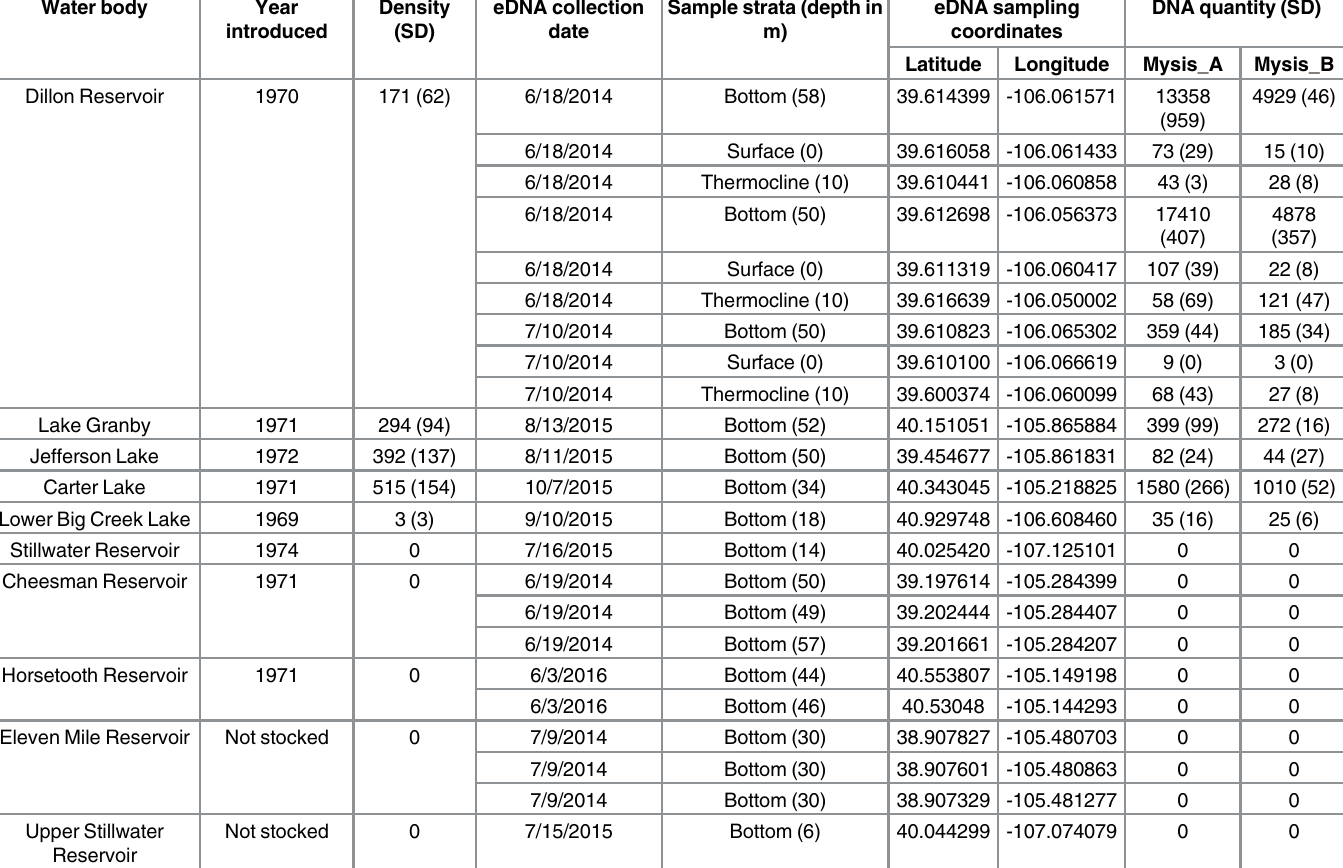
Table 3. Summary of sample collection and results. Year introduced refers to the earliest year of known M . diluviana stocking from Nesler et al. (1986). M . diluviana density (individuals /m 2 ) was estimated using traditional sampling methods. Density estimates were taken within 24 hours of eDNA collection. DNA was quantified using both markers and is listed in copies / L of water